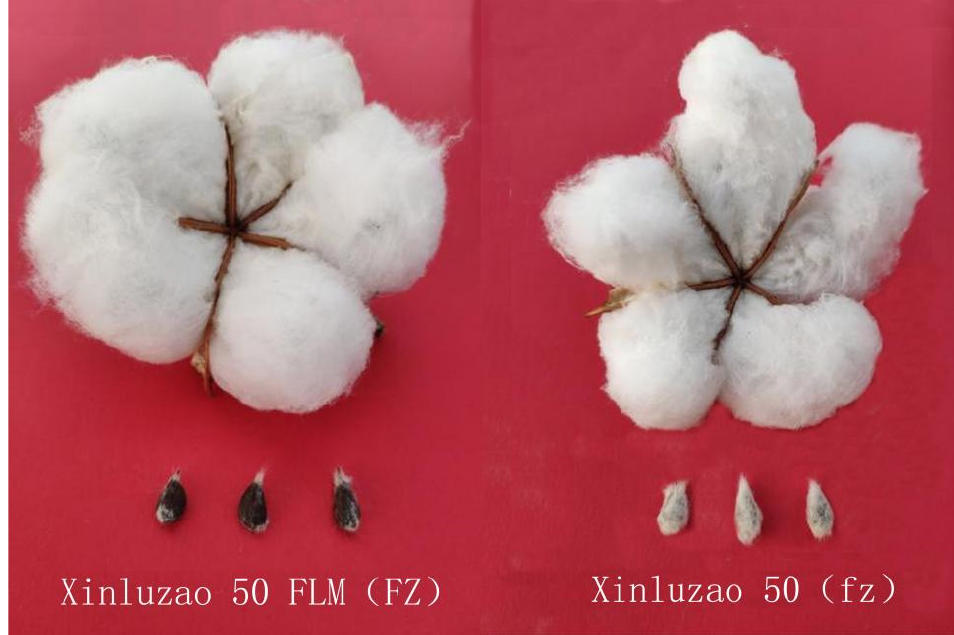
Figure 1. Wild type (fz) and fuzz mutant